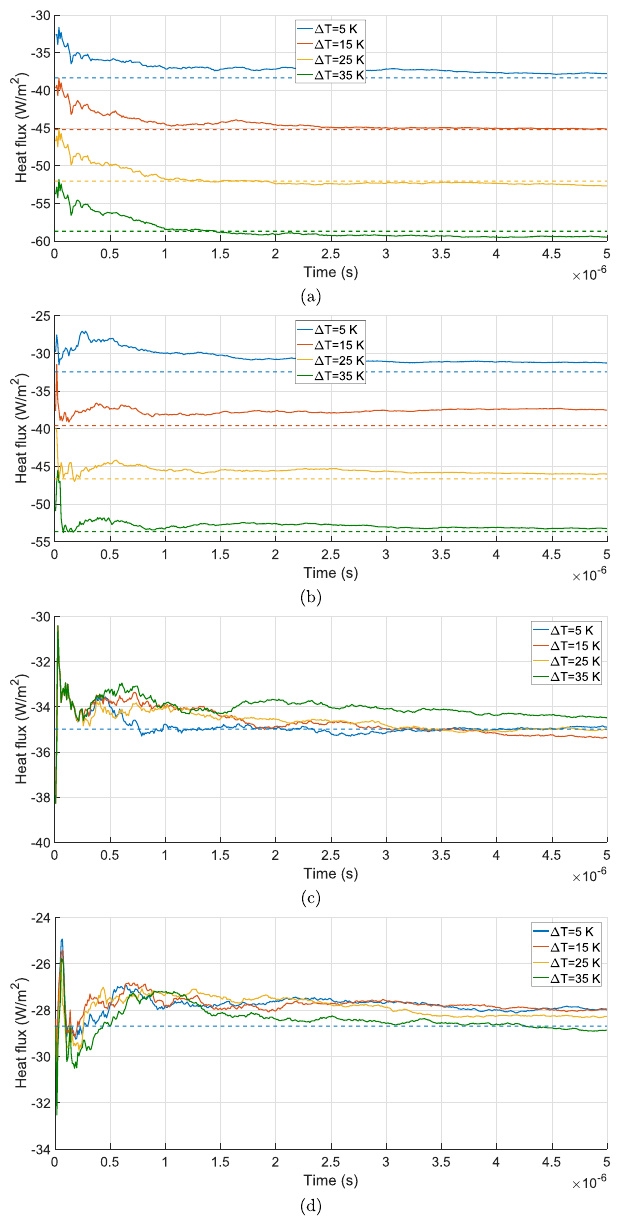
Figure 2. Comparison between the heat flux computed by the DSMC method (solid lines) and the one computed from the diffusive-approximate one (dashed lines) evaluated at the top ( a ) and bottom ( b ) surface of the hotter bolometer and at the top ( c ) and bottom ( d ) surface of the colder bolometer for different values of Δ T